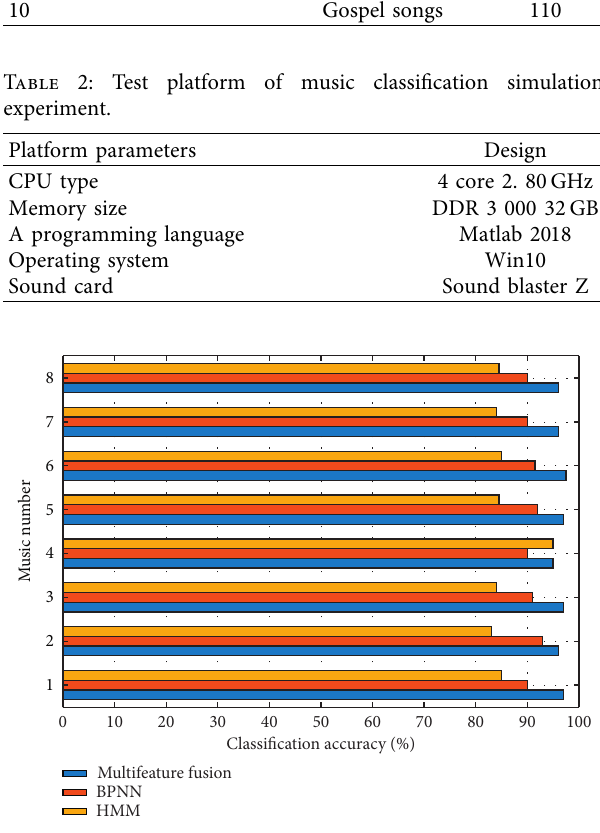
Figure 6: Comparison of accuracy of three music classification